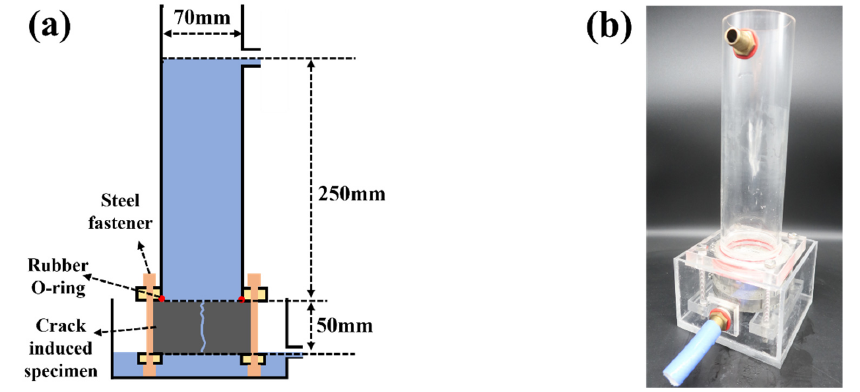
Figure 3. Water permeability test setup: ( a ) schematic of water permeability test setup; ( b ) picture of test